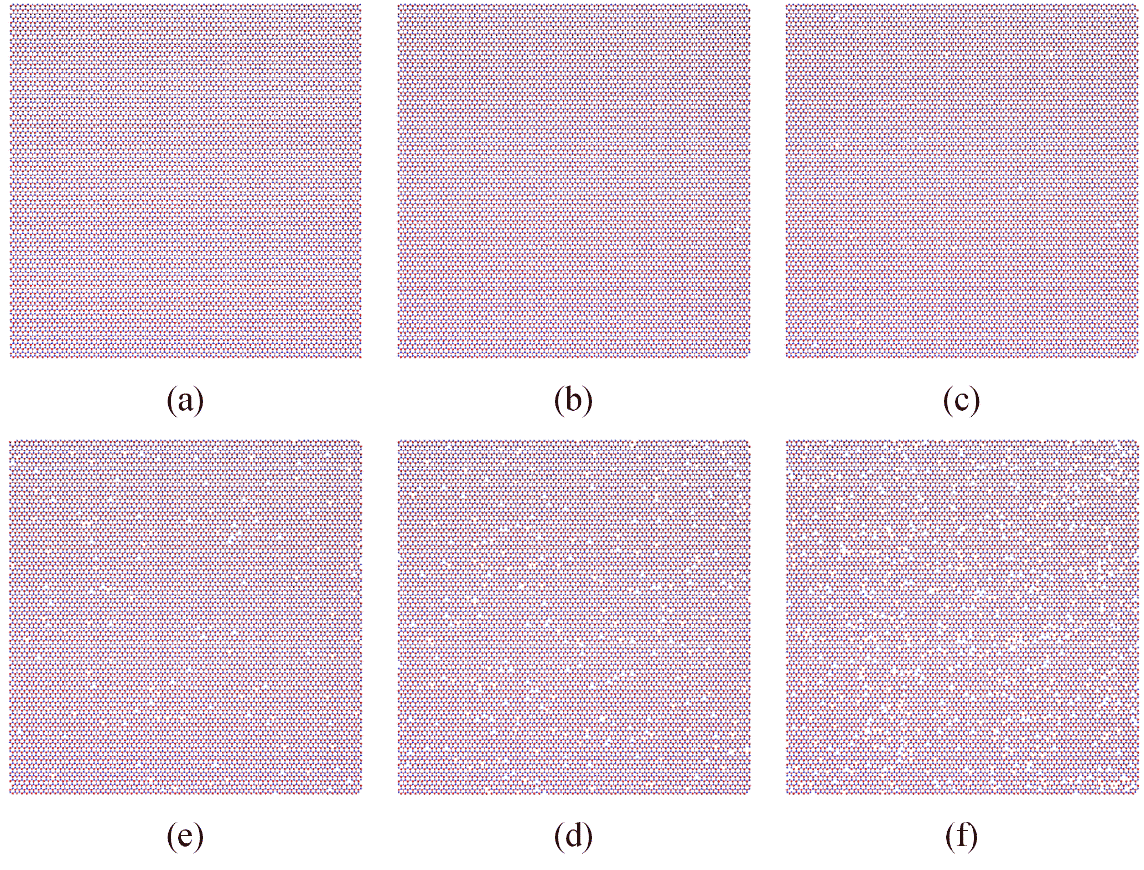
Figure 1: The simulation model of (a) perfect BNNS, (b) BNNS with 1 (0.01%) vacancy defect, (c) BNNS with 13 (0.1%) vacancies defect, (d) BNNS with 127 (1%) vacancies defect, (e) BNNS with 256 (2%) vacancies defect, and (f) BNNS with 636 (5%) vacancies defect and red dots indicate boron atoms and blue dots indicate nitride